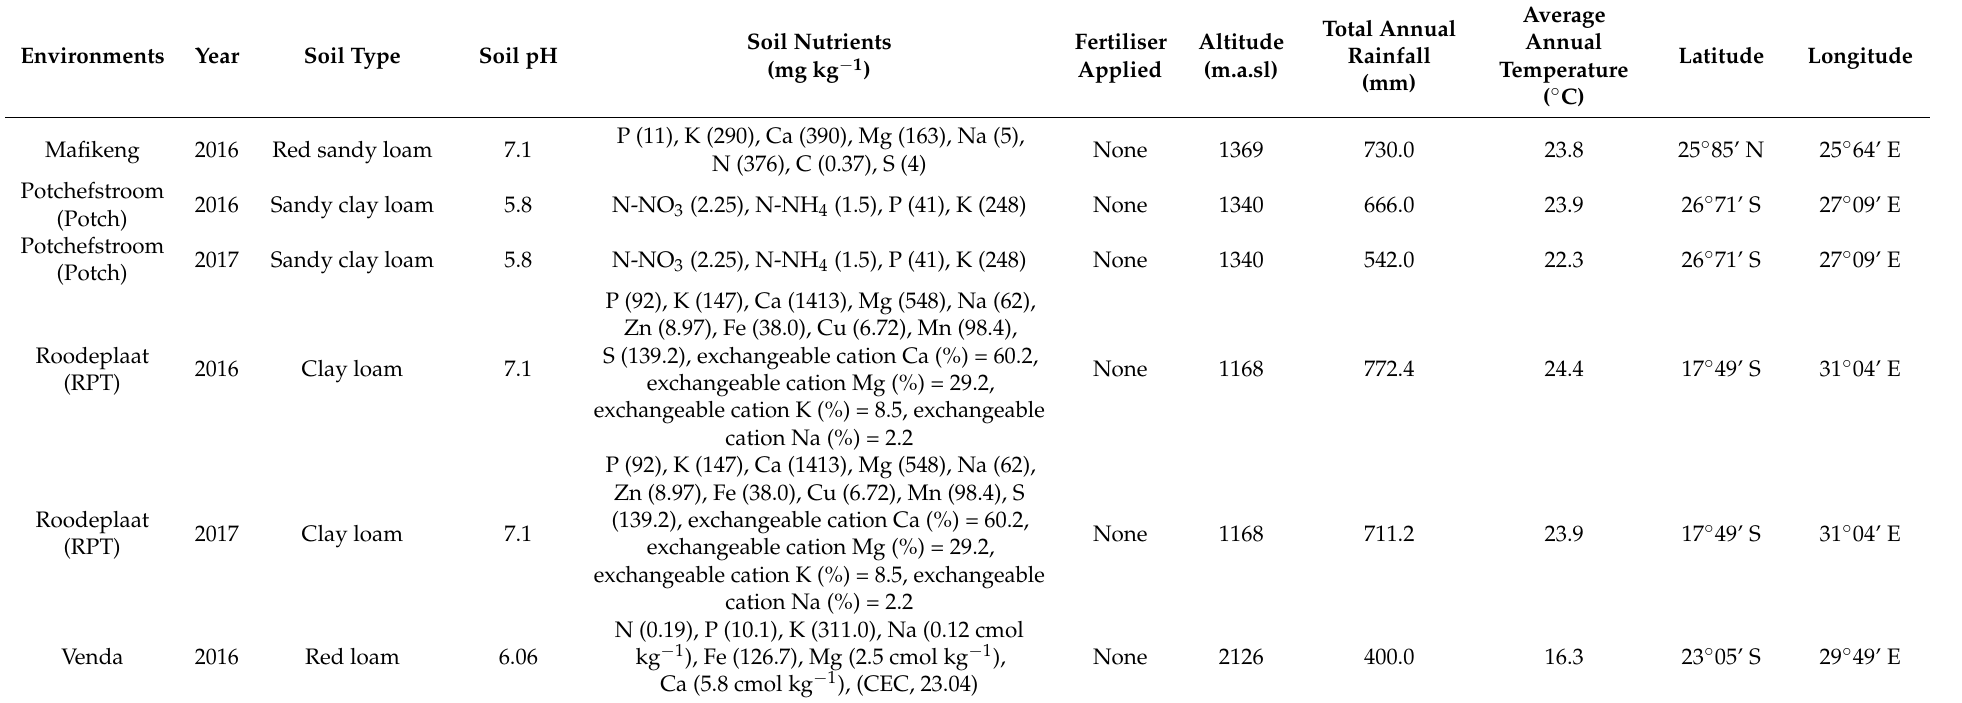
Table 2. Environmental characteristics of trial